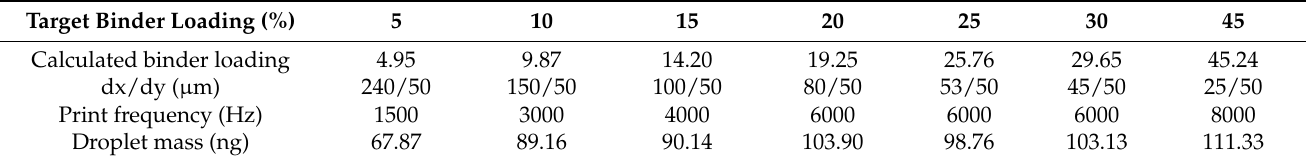
Figure 1. Print orientation of tensile roads in powder bed and measurement points for shape deviation analysis. Table 1. Print settings at different binder